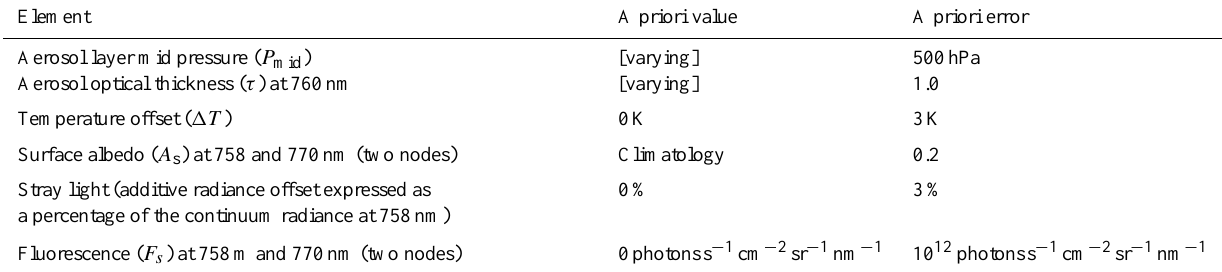
Table 6. State vector elements, a priori values and a priori (1 σ ) errors. In the default retrieval setup for the GOME-2A scene re- trievals (Sect. 7), only the first three or five parameters are fitted. Retrieval is attempted multiple times with different initial values for aerosol layer mid pressure and aerosol optical thickness. Fitting stray light or fluorescence emissions is only done in sensitivity experiments reported in Sect.